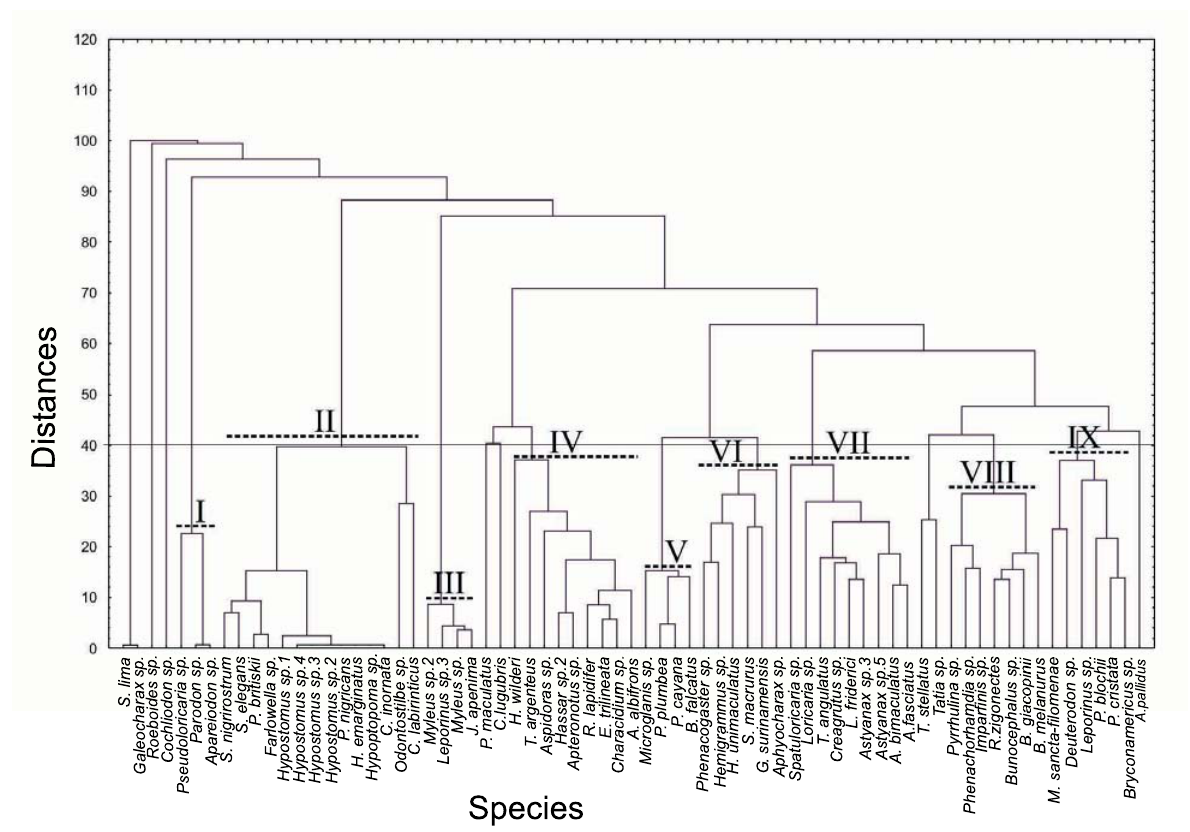
Fig. 3 . Tree diagram of the main trophic groups of fish from Córrego Fundo stream, based on stomach content analysis. Dashed lines indicate the trophic